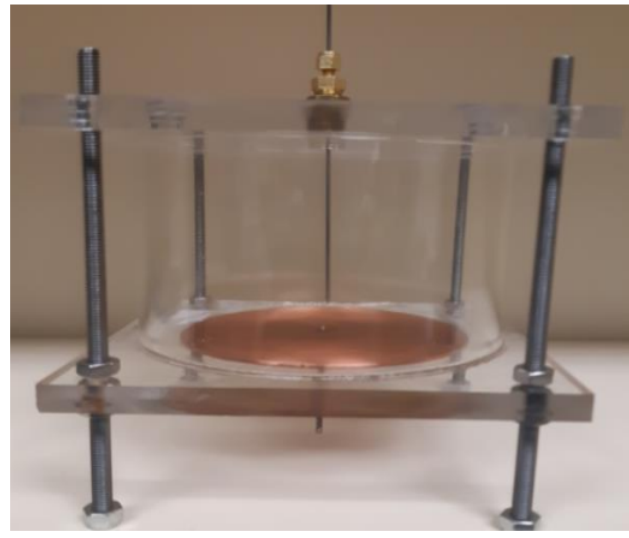
Figure 1. The view of a test